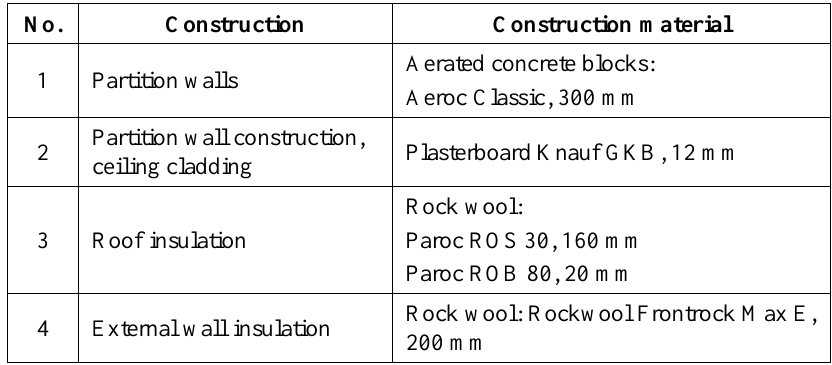
Table 1. Comparable Building